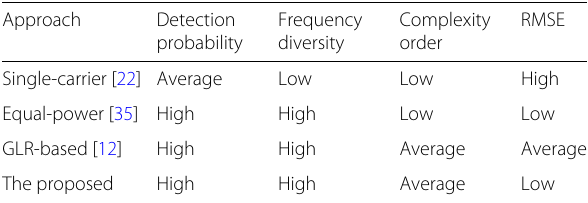
Table 1 Performance comparison of different approaches in low grazing angle target tracking scenario Approach Detection Frequency Complexity RMSE probability diversity order Single-carrier [22] Average Low Low High Equal-power [35] High High Low Low GLR-based [12] High High Average Average The proposed High High Average